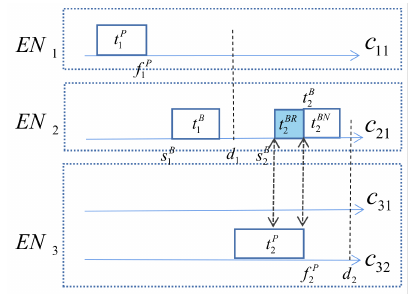
Figure 3. Time point of task